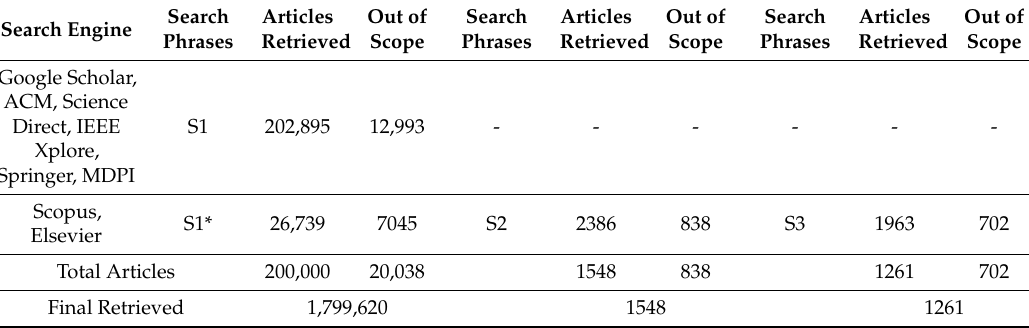
Figure 1. Methodology for shortlisting research articles for the study. Table 1. Initial article retrieval — phase 1 (year 2010 – 2020).